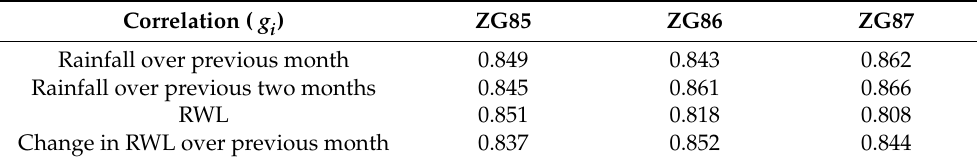
Table 2. Correlation of the influence factor with the period term of each monitoring